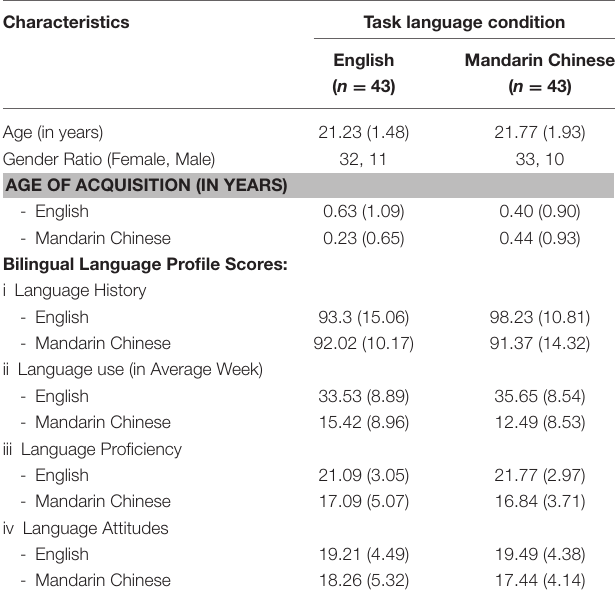
Language background was measured by the Bilingual Language Profile (Birdsong et al., 2012). Means and standard deviations are reported for each group condition, where